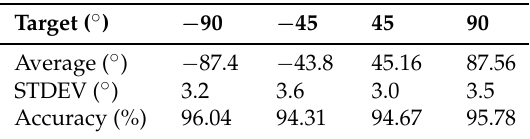
Figure 17. Test environment for user-motion recognition and synchronization. Table 4. Results of user-motion recognition and synchronization test.